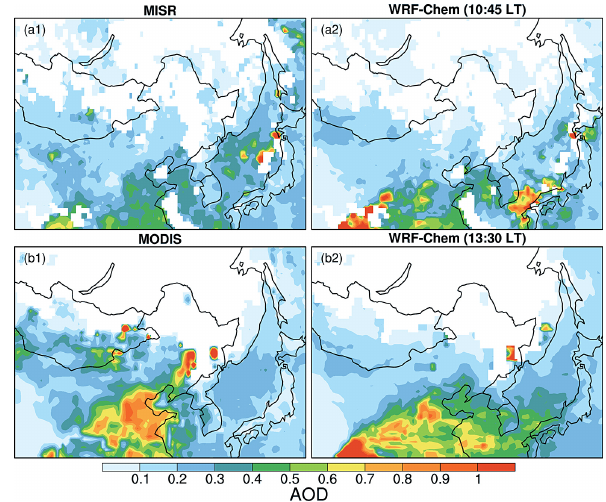
Figure 7. (a) BC mass concentrations in the top snow layer from the campaign observations (black) and the corresponding WRF-Chem simulations (red). The box plot of observations shows the minimum and maximum possible values from estimates and the bar within the box shows the most likely value; the whisker bar of model results shows the 10th and 90th percentiles of simulated hourly values of January–February. The asterisk represents the 24h average value for January–February. The box of model results shows the 10th and 90th percentiles of simulated values at observation sampling hour of January–February. The bar within the box represents the simu- lated value at the observation sampling hour and day. (b) Ratio (red circles) of BC mass concentration in the top snow layer from the model at the observation sampling time and observation along with latitudes (green line).